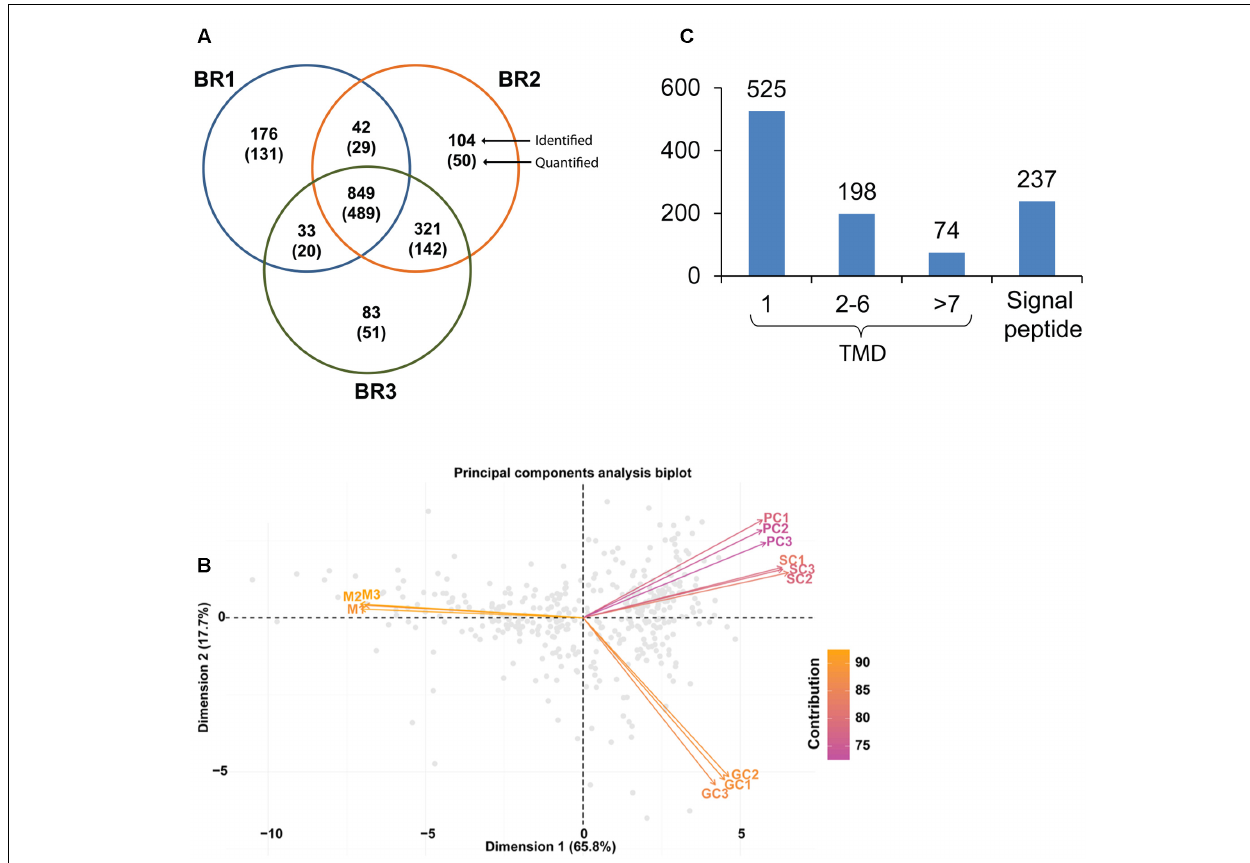
FIGURE 2 | (A) Venn diagram showing the number of unique proteins identified and quantified from the iTRAQ analysis of three biological replicates (BR1, BR2, and BR3) corresponding to the four developmental stages; (B) principal component analysis (PCA) was performed on all normalized iTRAQ intensities from proteins which had a p -value equal to or less than 0.01. The resulting biplot used the two principal component model (PC1 and PC2) with component contributions of 65 and 17%, respectively. The biplot shows proteome data (intensities) as labeled dots for all biological replicates (M1, M2, and M3; PC1, PC2, and PC3; SC1, SC2, and SC3; GC1, GC2, and GC3), with average intensities shown as vectors. Vectors that are closer together are more highly correlated in terms of the observed proteome while vectors that are orthogonal are less correlated; (C) total number of identified proteins containing one or more transmembrane domains (TM), and with signal